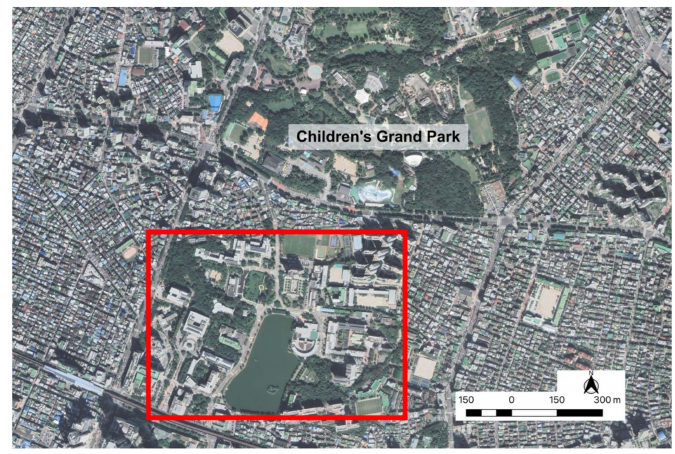
Figure 2. Study site (marked with the red box, 473,565 m 2 ) and surroundings.